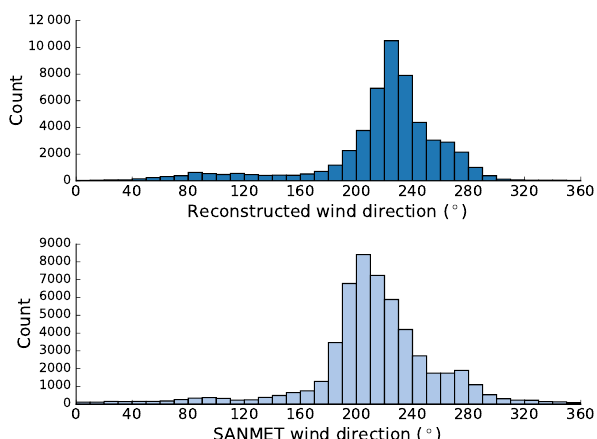
Figure 24. Statistical distributions of wind directions during VL1 sols 1–45.